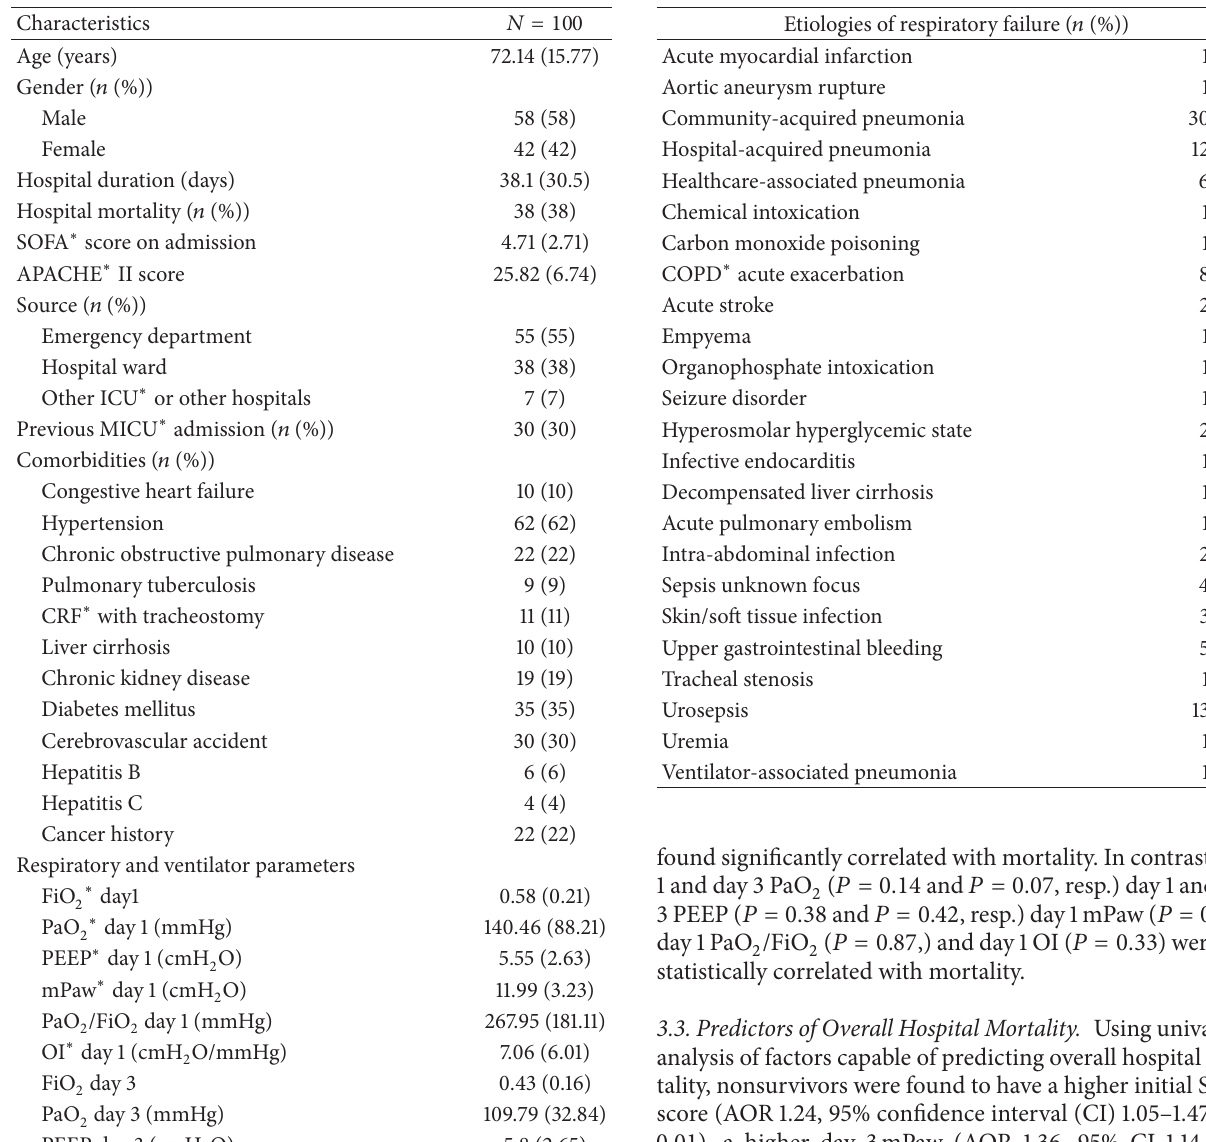
Table 1: Baseline characteristics of patients. Table 2: Etiologies of severe acute respiratory